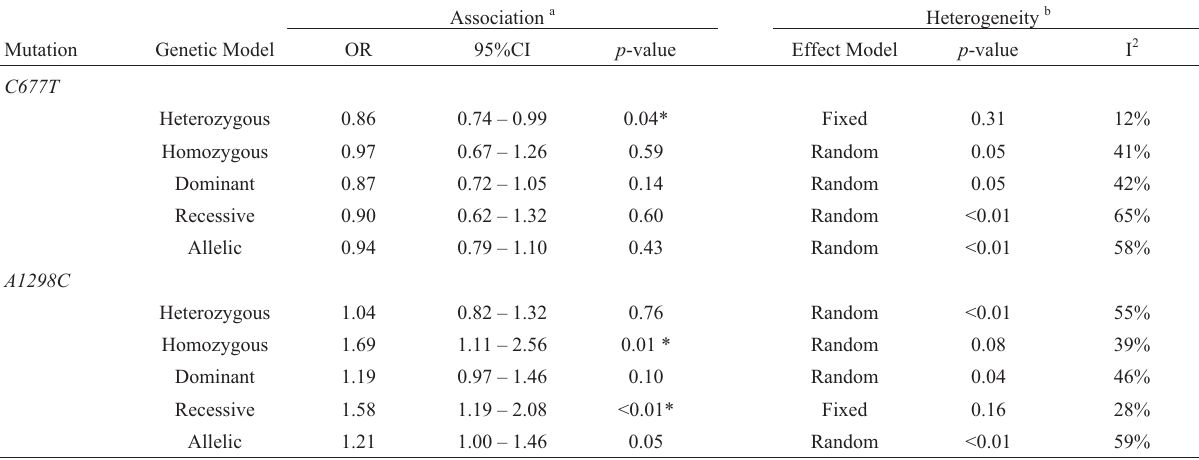
Table 2 - Association between the MTHFR polymorphisms and developing hematological cancers in Latin Americans.